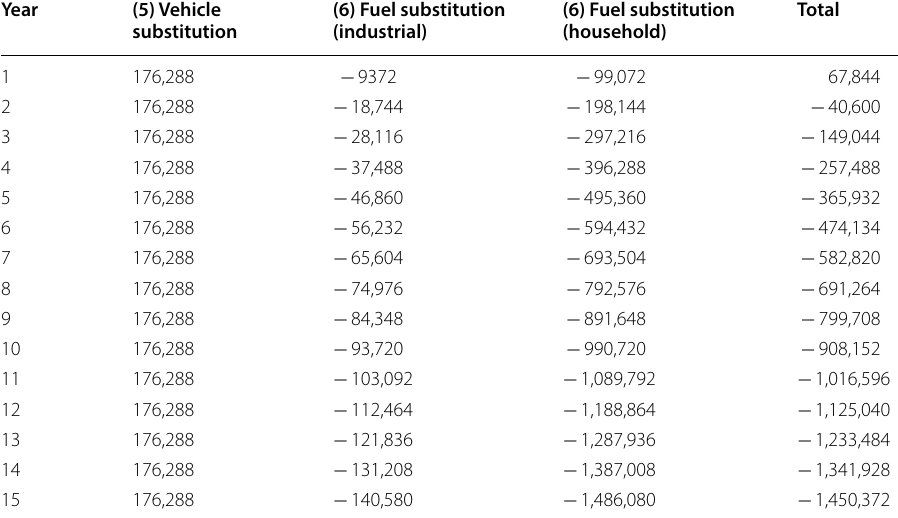
Table 12 Hydrogen production by direct decomposition of methane: Indicative of accumulated effect only (Unit: t-CO